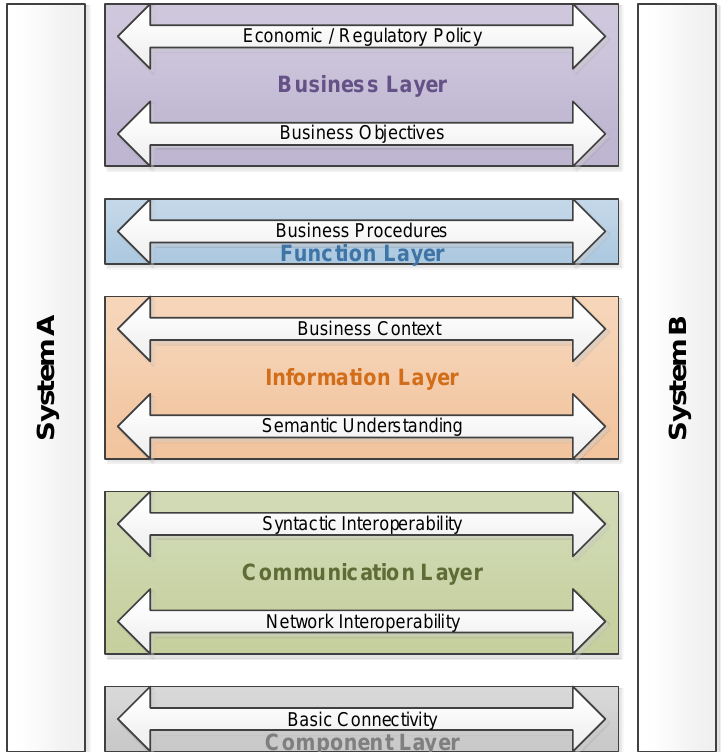
Figure 1. GridWise architecture council (GWAC) and smart grid architecture model (SGAM) layer models (adopted from